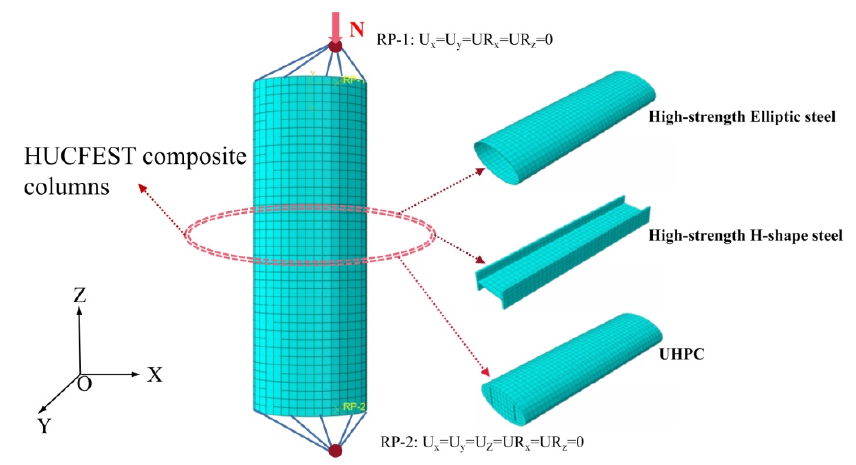
Figure 2. The FE models for the 44 HUCFESTCs.